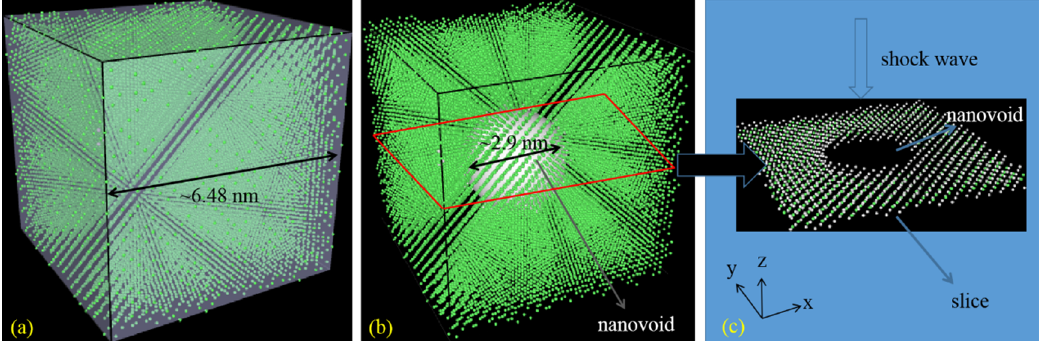
Figure 1. Schematic of ( a ) voids-free system, ( b ) nanovoid-containing system, and ( c ) a slice of the nanovoid-containing system.